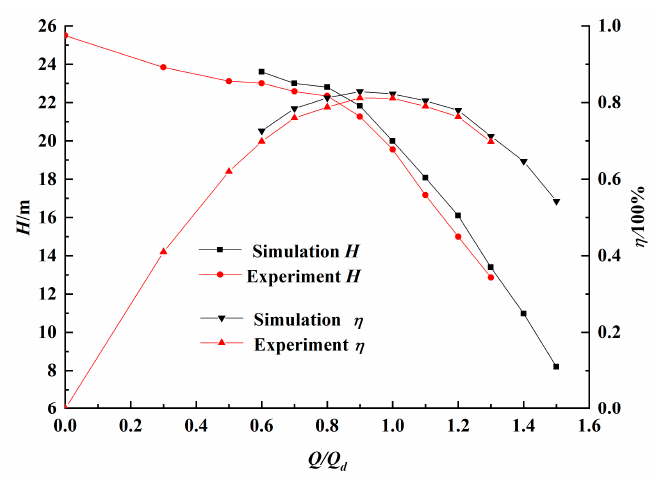
Figure 5. Characteristic curves of simulation and experiment.